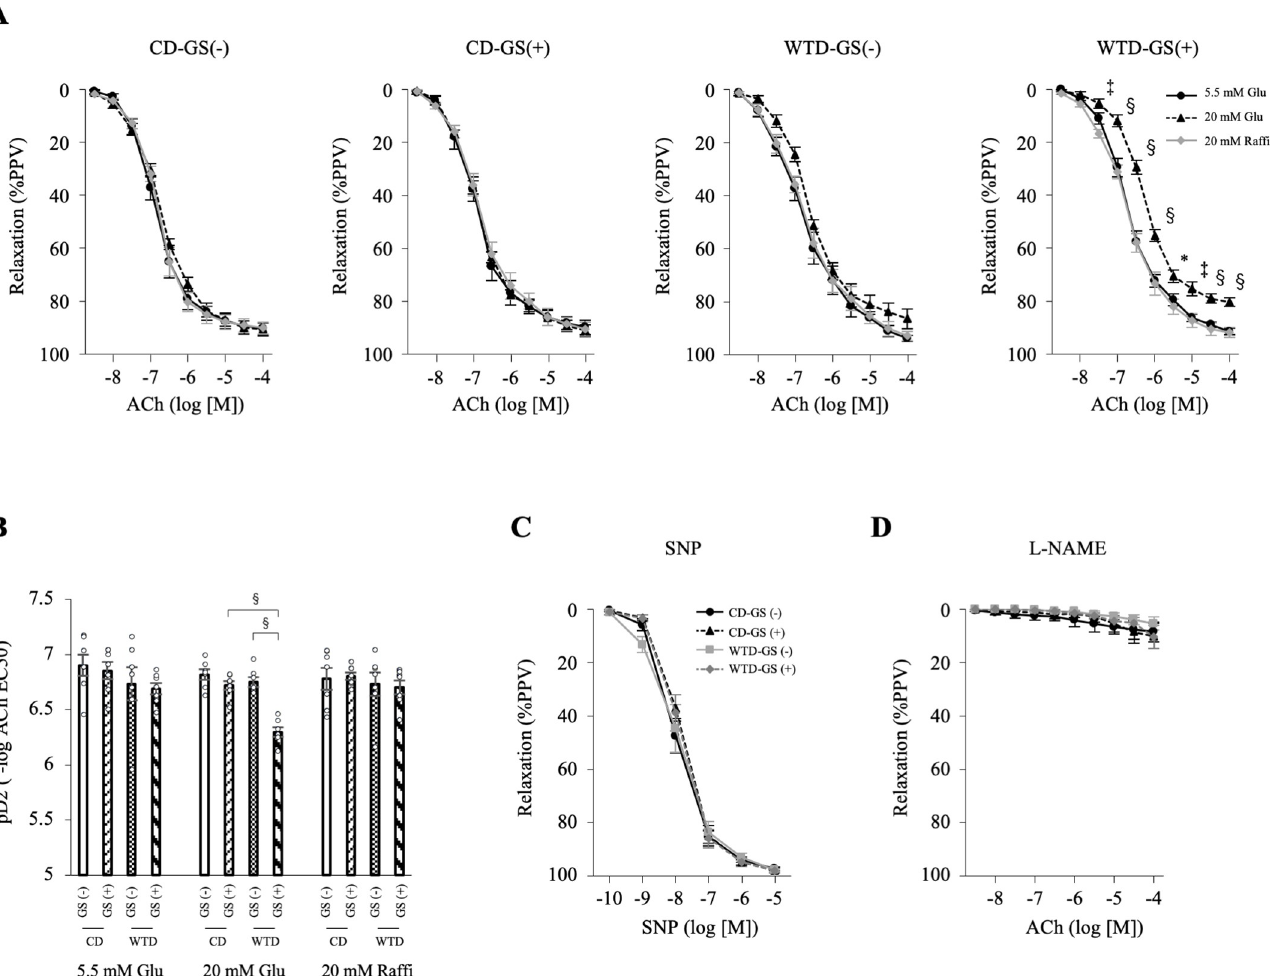
Fig 2. GSs deteriorate endothelium-dependent relaxation in diet-induced obese rats. A: Curves of EDR in the thoracic aorta in response to ACh under 5.5 mM glucose, 20 mM glucose and 20 mM raffinose conditions. � P < 0.05, ‡ P < 0.005, § P < 0.001 compared with 5.5 mM glucose and 20 mM raffinose in the WTD-GS (+) group, one-way repeated-measures ANOVA with the Bonferroni post hoc test. B: Vascular sensitivity, plotted as pD2 (- log of the half-maximal effective concentration [EC50]) of ACh. A significant interaction was detected between diet and GS factors under 20 mM glucose conditions. § P < 0.001, two-way ANOVA followed by a simple-effects analysis. C: Curves of vasorelaxation in response to SNP under 20 mM glucose conditions (7 rats per group). D: Curves of EDR in response to ACh in the presence of L-NAME and 20 mM glucose, two-way repeated-measures ANOVA. The data are presented as the means ± SEM. N = 7 rats per group. Glu, glucose; Raffi, raffinose; ACh, acetylcholine; SNP, nitroprusside; L-NAME, an NO synthase inhibitor; CD, control diet; WTD, Western- type diet; GS, glucose